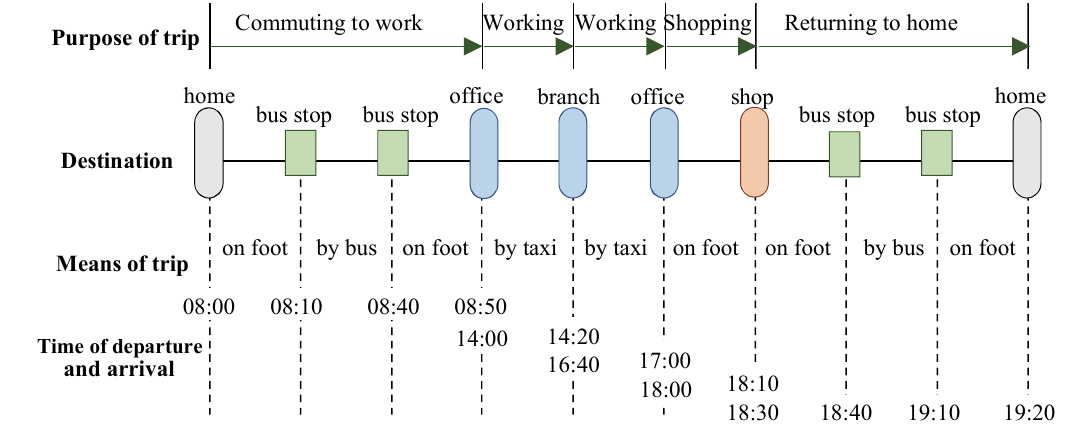
Figure 2. Examples of trips in Person Trip survey data. Table 1. Details about Person Trip survey data.